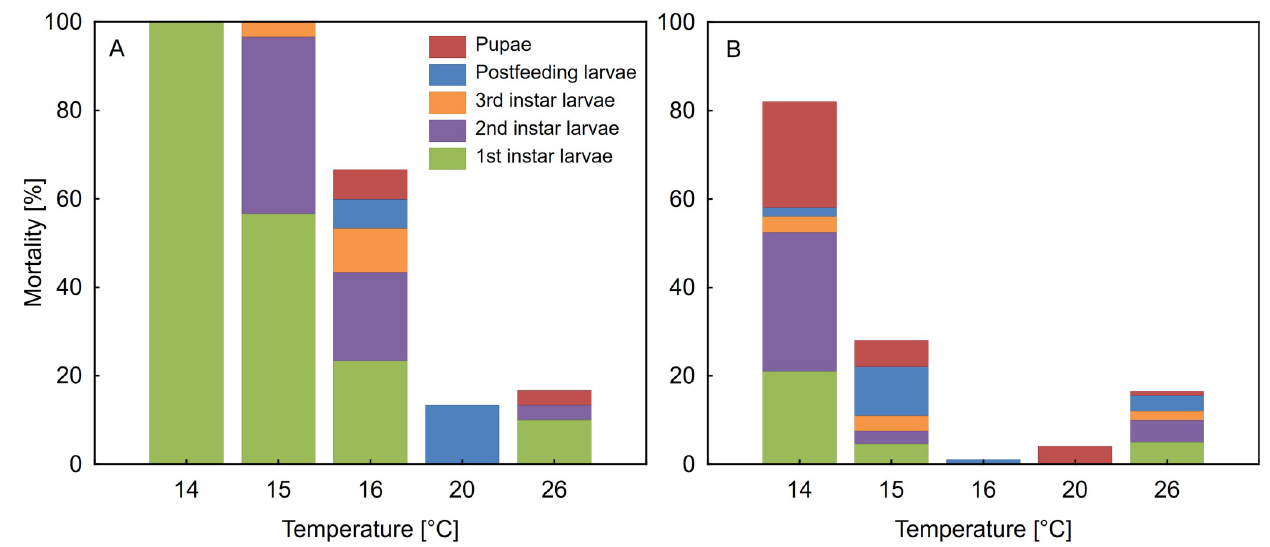
Fig 1. Mortality of Necrodes littoralis at preimaginal stages reared individually (A) and in aggregations (B).